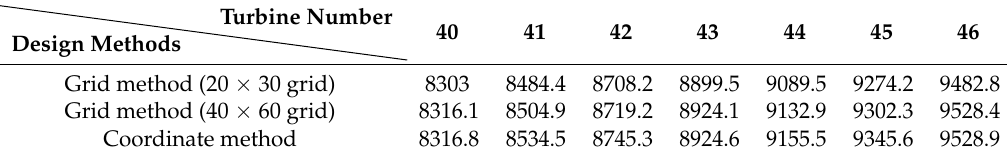
Table 5. Comparison of the optimized total wind farm power output (in kW) with different wind farm design methods in a finer 3 ◦ angular resolution of wind